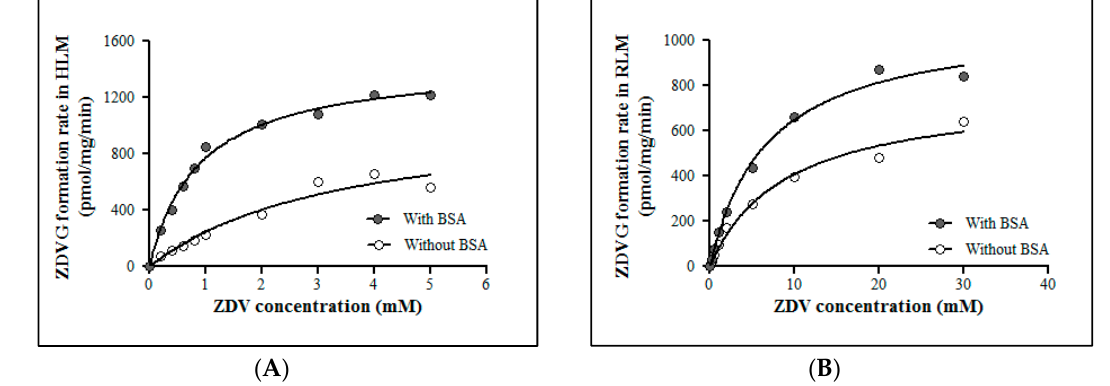
Figure 3. Michaelis-Menten plots for zidovudine (ZDV) glucuronidation catalyzed by ( A ) human liver microsomes (HLM) and ( B ) rat liver microsomes (RLM) with and without 1% ( w / v ) of bovine serum abumin (BSA). Each point represents the mean of zidovudine glucuronides (ZDVG) formation rate ± standard deviation (SD) for triplicates ( n = 3). Table 4. Derived kinetic constants for zidovudine glucuronidation in human (HLM) and rat liver microsomes (RLM) obtained from the incubation with and without 1% ( w / v ) bovine serum albumin (BSA). Data are presented as mean ±